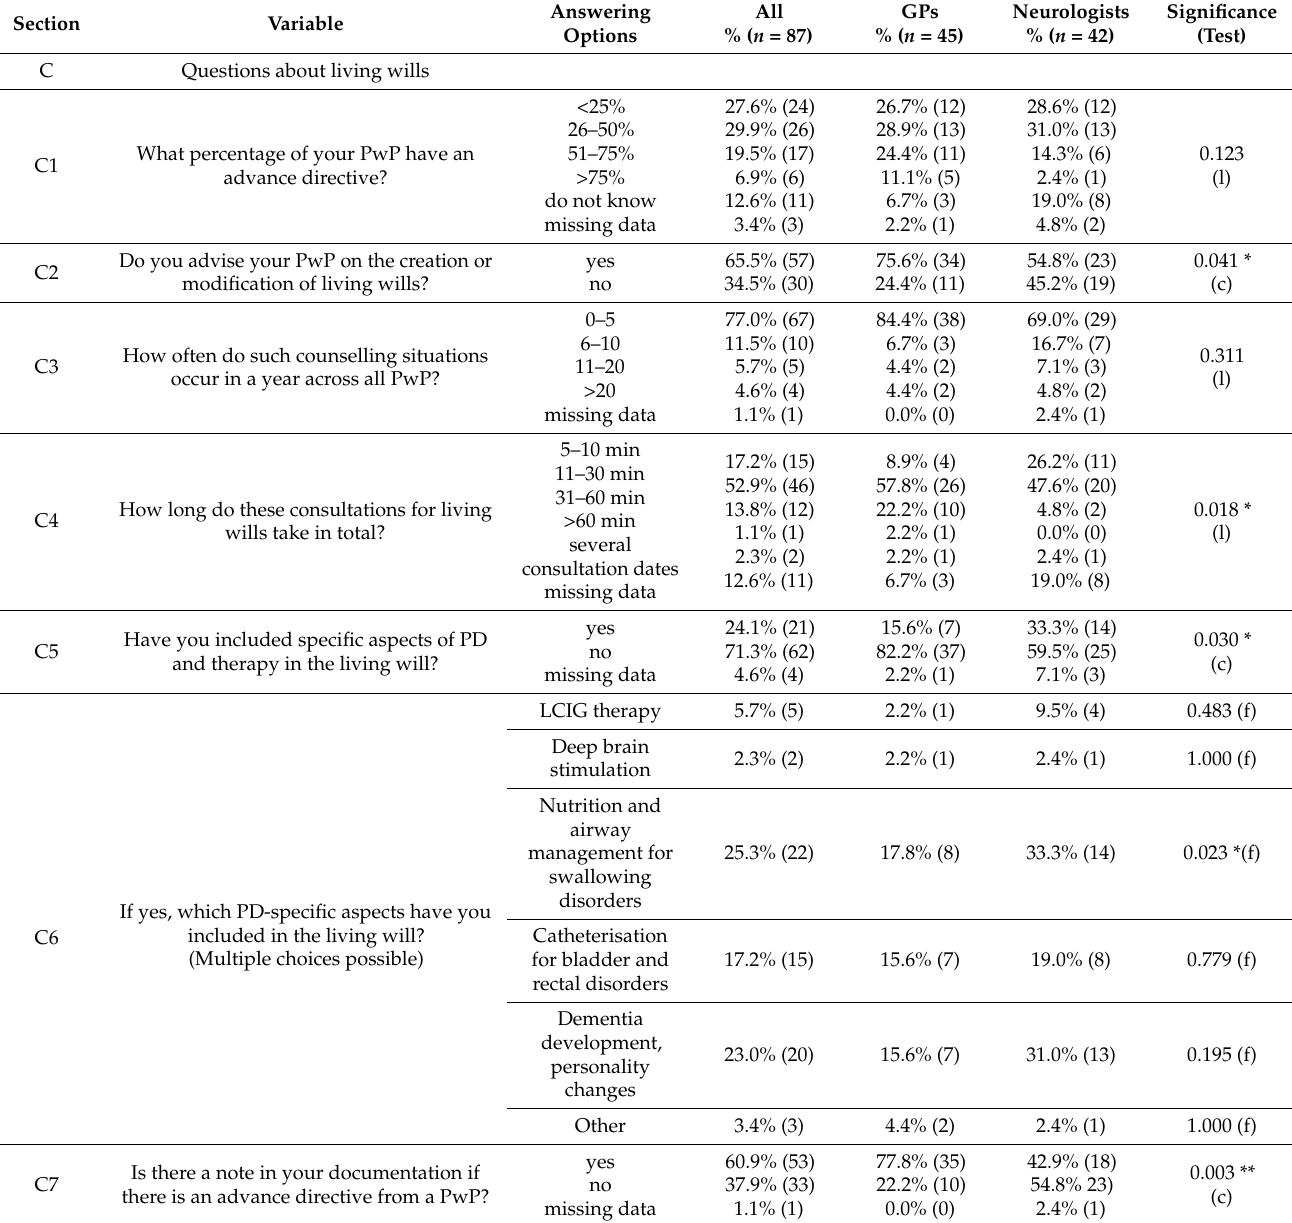
Table 3. Supply with PD-specific advance directives in outpatient